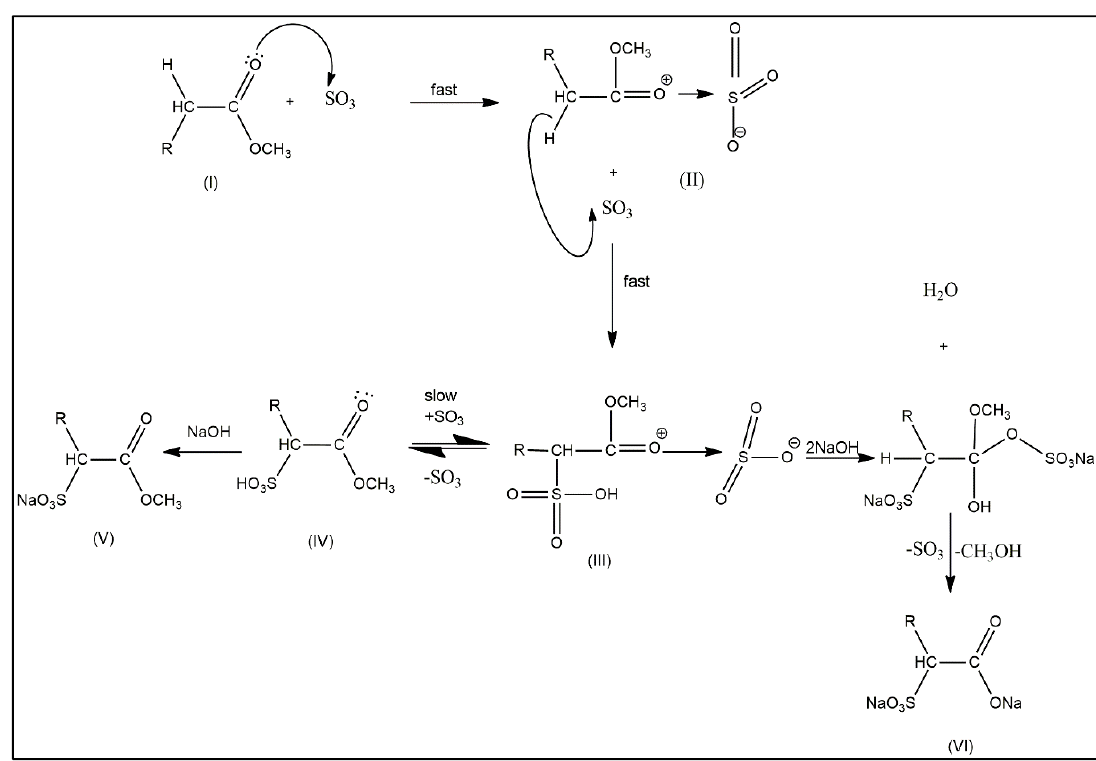
Figure 2. Reaction of methyl ester sulphonates (V) and the intermediates, such as di-salt (VI).